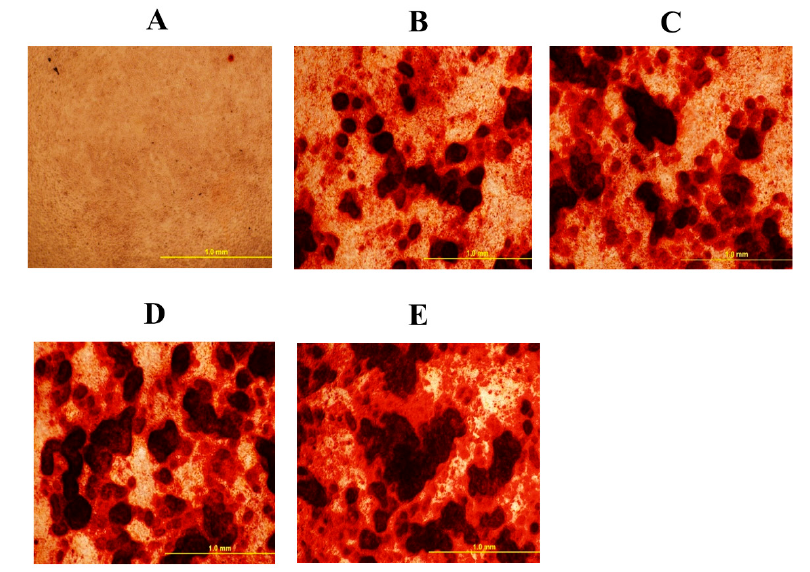
Results indicated that 10 µ M 20S could induce a stimulatory e ff ect on the osteogenic di ff erentiation